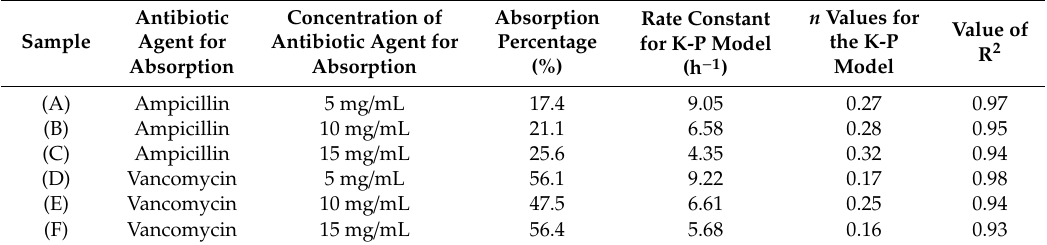
Table 1. The absorption percentages and parameters for drug release profiles with various antibiotic agents used in this